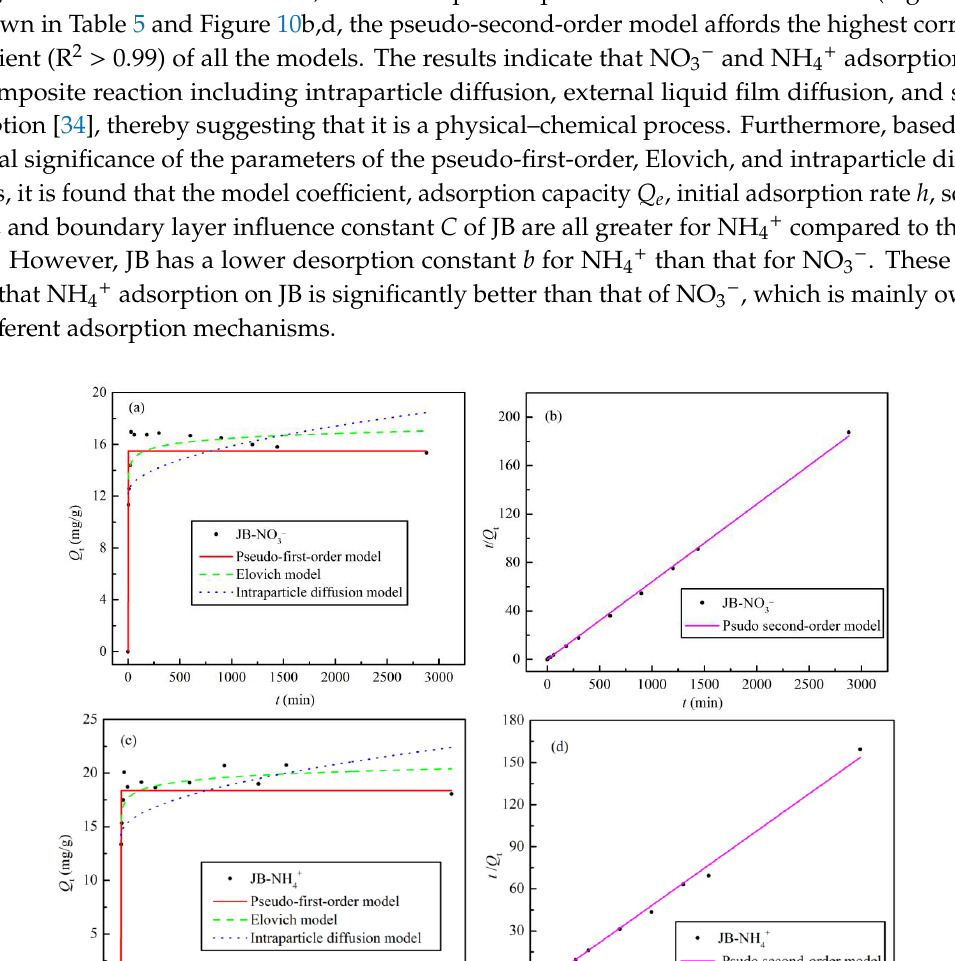
Figure 10. Adsorption kinetics models fitting curves of JB. ( a , b ) for NO 3 − at different models, ( c , d ) for NH 4+ at different models.